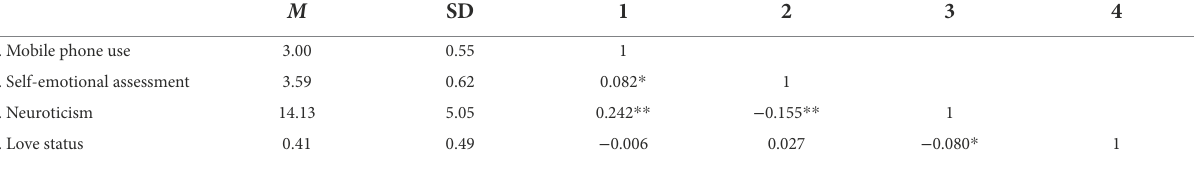
TABLE 1 Descriptive statistics and correlations among all